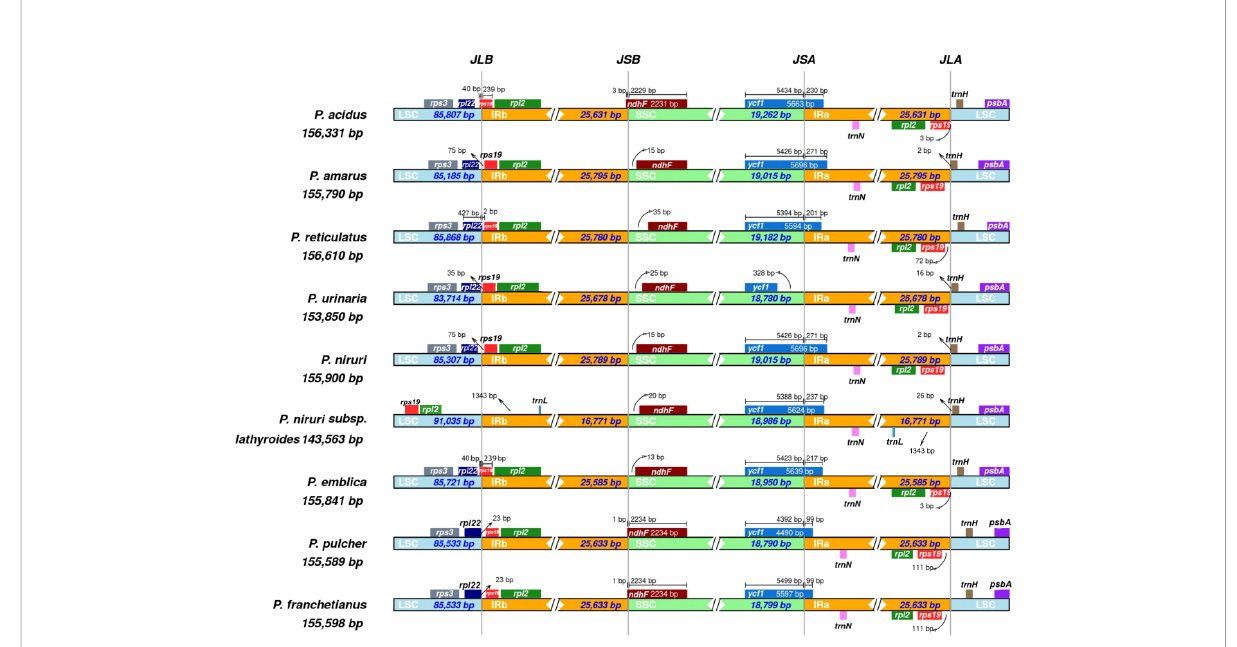
FIGURE 3 Comparisons of the borders of LSC, SSC, and IRa/b regions among the nine Phyllanthus cp genomes. The numbers represent the distance between the gene ends and the border sites, and the numbers below represent the length of the LSC, SSC, and IRa/b